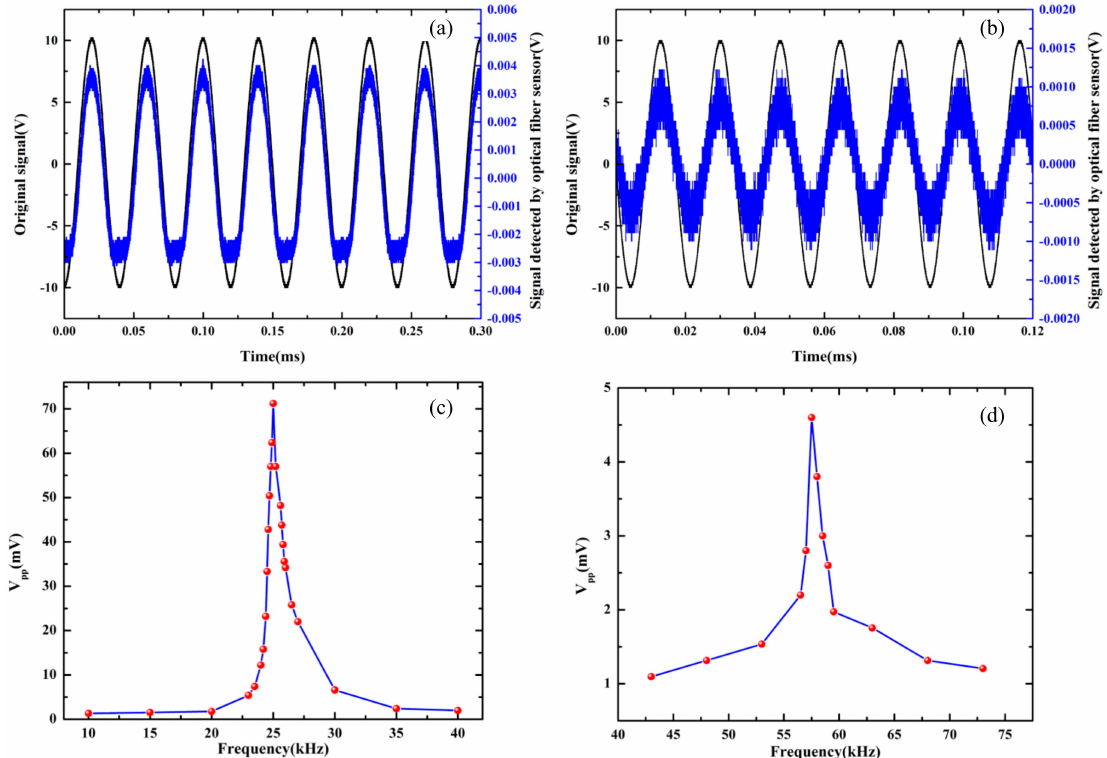
Figure 5. Comparison of original exciting signals (in black) and detected signals (in blue) of the optical fiber sensor at ( a ) 25 kHz and ( b ) 58 kHz. Frequency response characteristics for the ultrasonic transducer of ( c ) 25 kHz and ( d ) 58